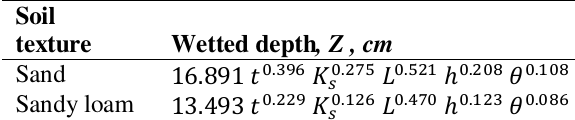
Empirical formulas to predict the wetted depth. Soil texture Wetted depth , Z , cm